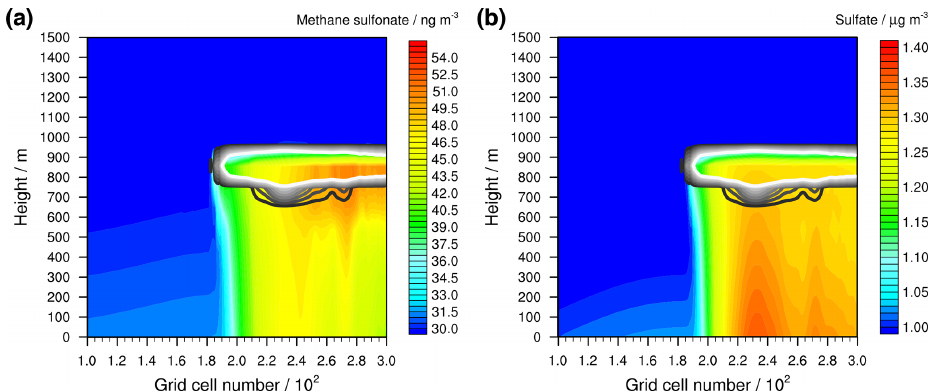
Figure 10. Simulated aqueous-phase concentrations of (a) methane sulfonate and (b) sulfate in the stable meteorological condition simulation with stratiform clouds after 12h of modelling time. The x axis represents the innermost horizontal grid cells divided by 100. The black contour lines represent the simulated clouds. The black line corresponds to a LWC of 0.01gm − 3 and the white line to 0.1gm − 3 . The area framed by the white line includes LWC above 0.1gm − 3 . The initial background concentration of methane sulfonate is at about 30ngm − 3 and that of sulfate at 1µgm 3